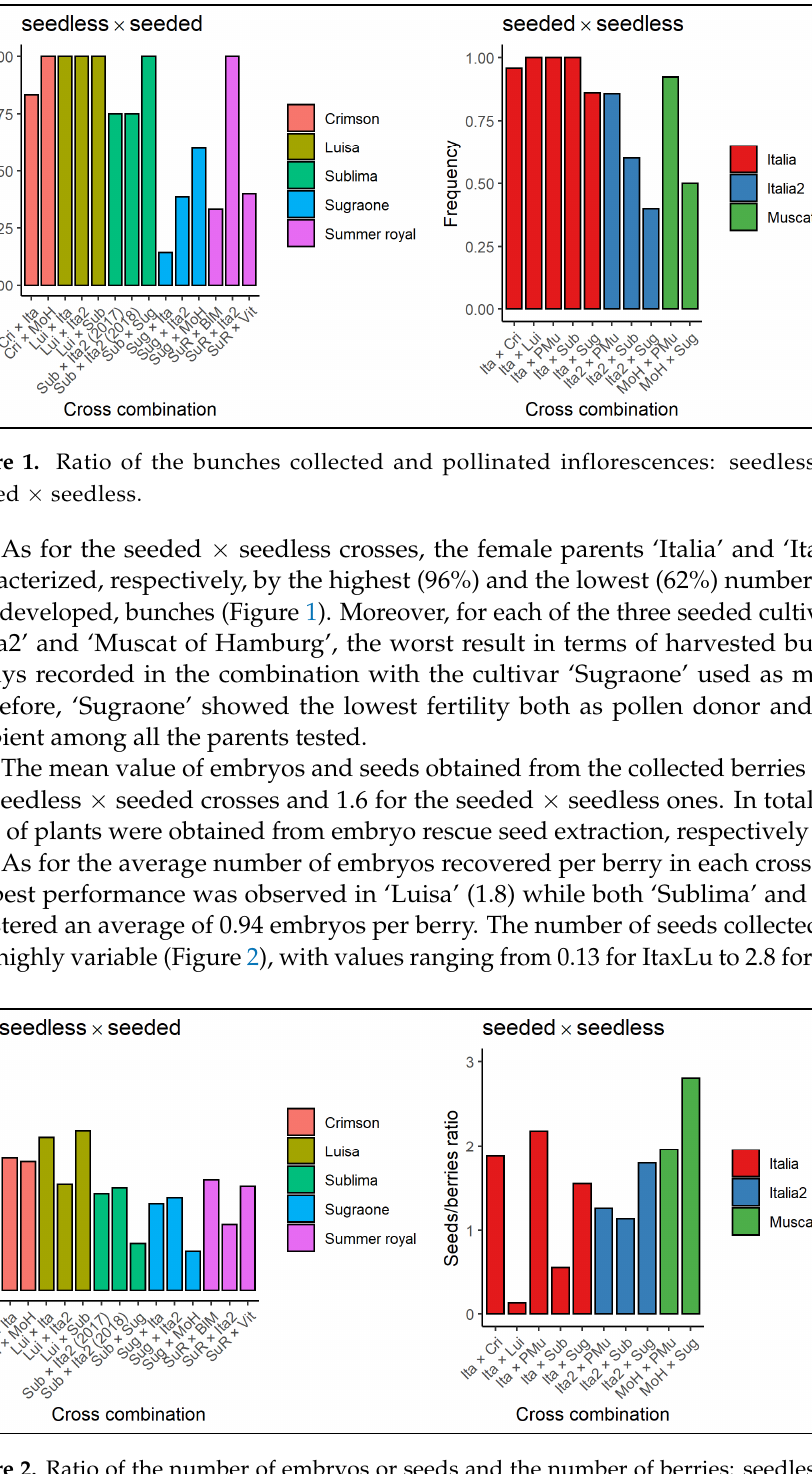
Figure 2. Ratio of the number of embryos or seeds and the number of berries: seedless × seeded; seeded × seedless.